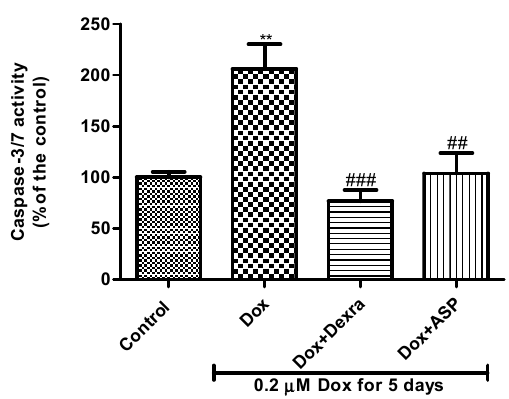
Figure 4. The effect of aspalathin (ASP) on caspase 3/7 activity on H9c2 cells treated with 0.2 µ M Dox for 5 days. H9c2 cells were treated with 0.2 µ M Dox alone or in combination with either 20 µ M dexrazoxane (Dexra) or 0.2 µ M ASP daily for 5 days. Control samples were exposed to media only. Results are expressed as the mean ± SEM of three independent biological experiments, each with three technical replicates ( n = 9). ** p < 0.01 versus control and ## p < 0.05 and ### p < 0.01 versus Dox.